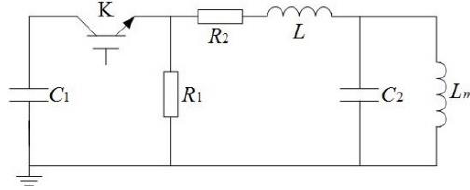
Figure 3. SI discharge equivalent circuit with IGBT.